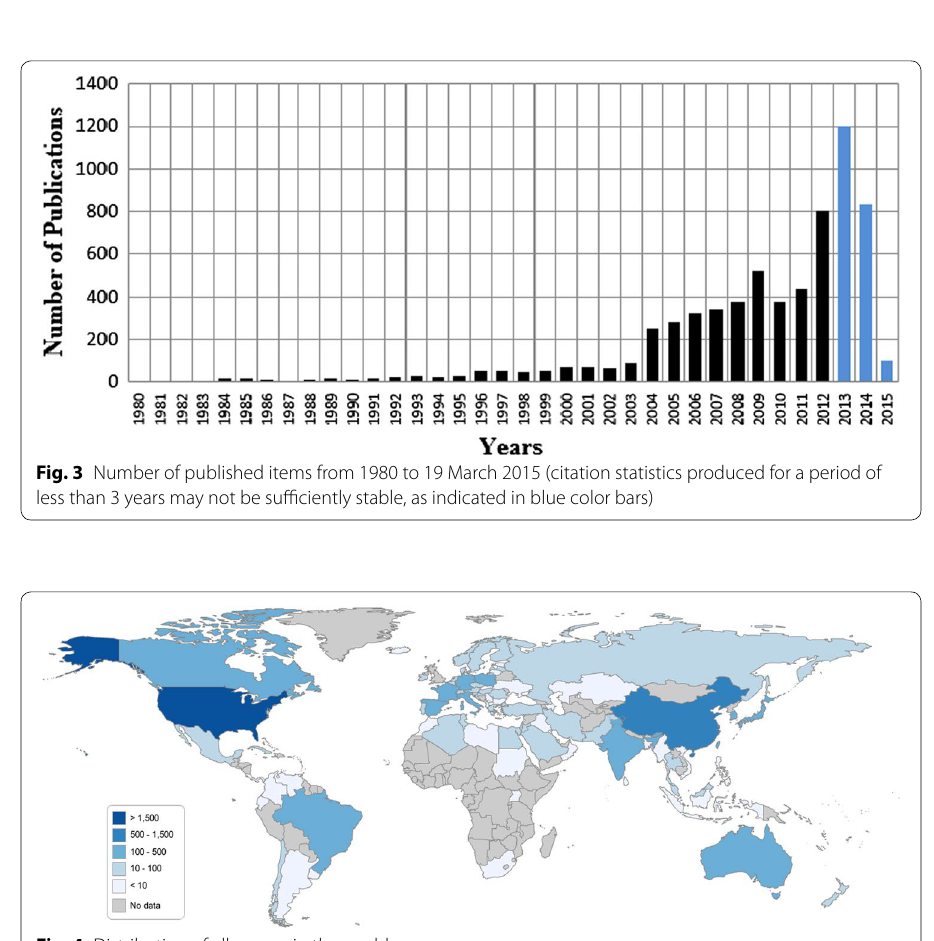
Fig. 4 Distribution of all papers in the